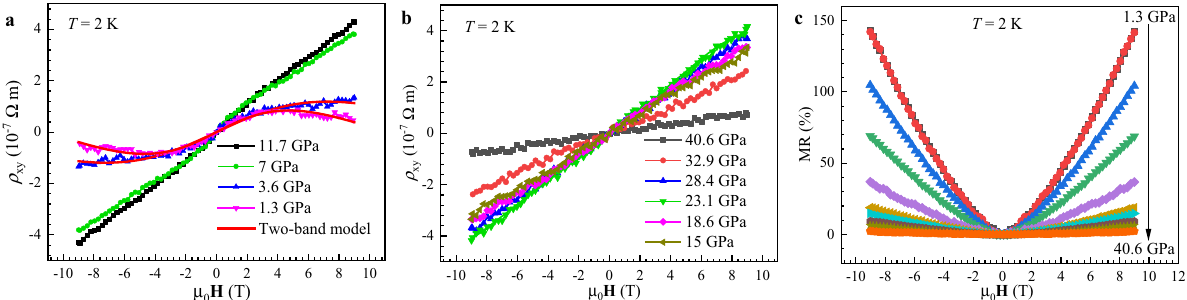
Fig. 3 Pressure effects on Hall resistivity and magnetoresistance. a Nonlinear magnetic fi eld dependence of Hall resistivity ρ xy ( B ) with pressures below 11.7 GPa. The red lines are fi ttings according to two-band model. b Linear ρ xy ( B ) curves with pressures up to 40.6 GPa. c The magnetoresistance MR( B ) under pressures up to 40.6 GPa.